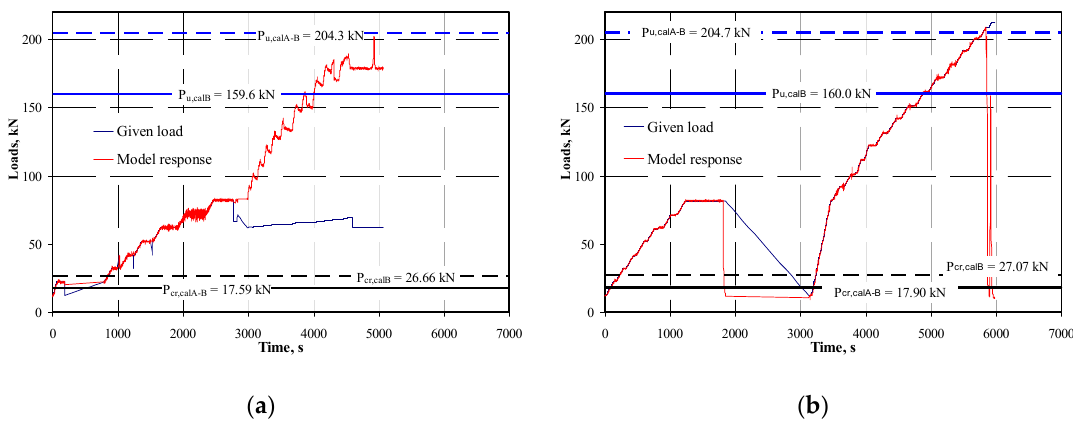
Figure 17. Changes in imposed load and recorded response of structure in a function of time: ( a ) Beam No. 1, ( b ) Beam No. 2.